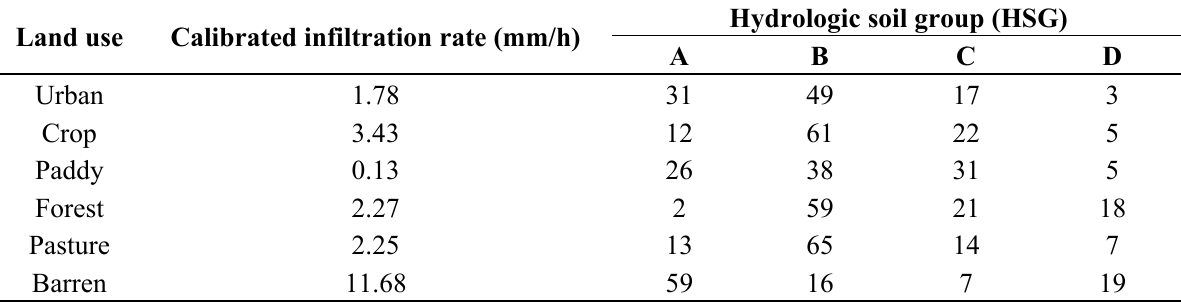
Table 9. The comparison of hydrologic soil conditions with land use type at study area. Land